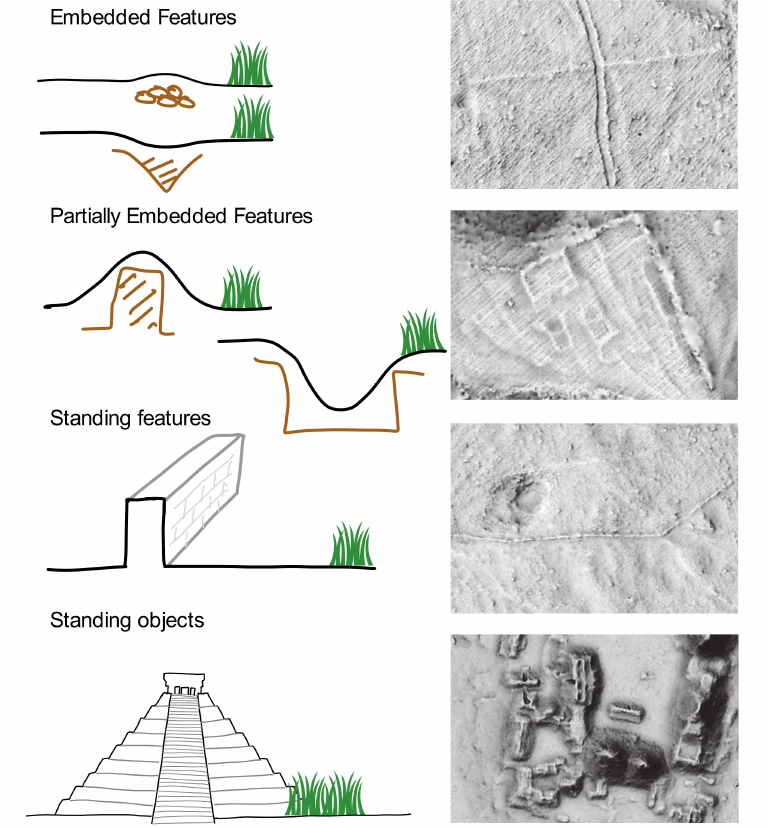
Figure 2. Morphological types of archaeological features detectable on DFM (after [32]: Figure 5, published under CC-BY